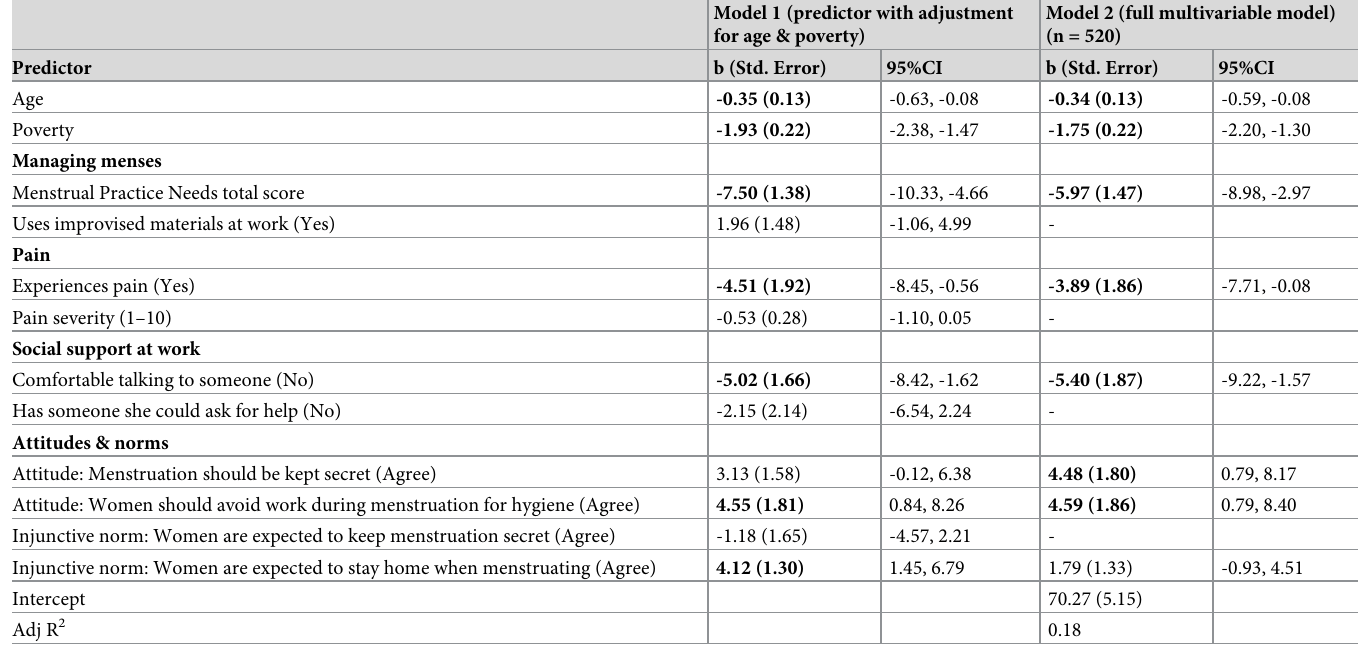
Table 5. Associations between reported menstrual health needs and wellbeing measured using the WHO-5.